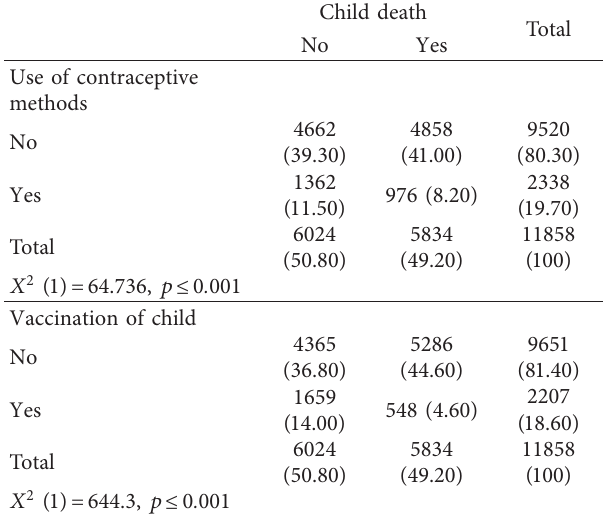
Table 13: Use of contraceptive methods and child vaccination on child mortality.